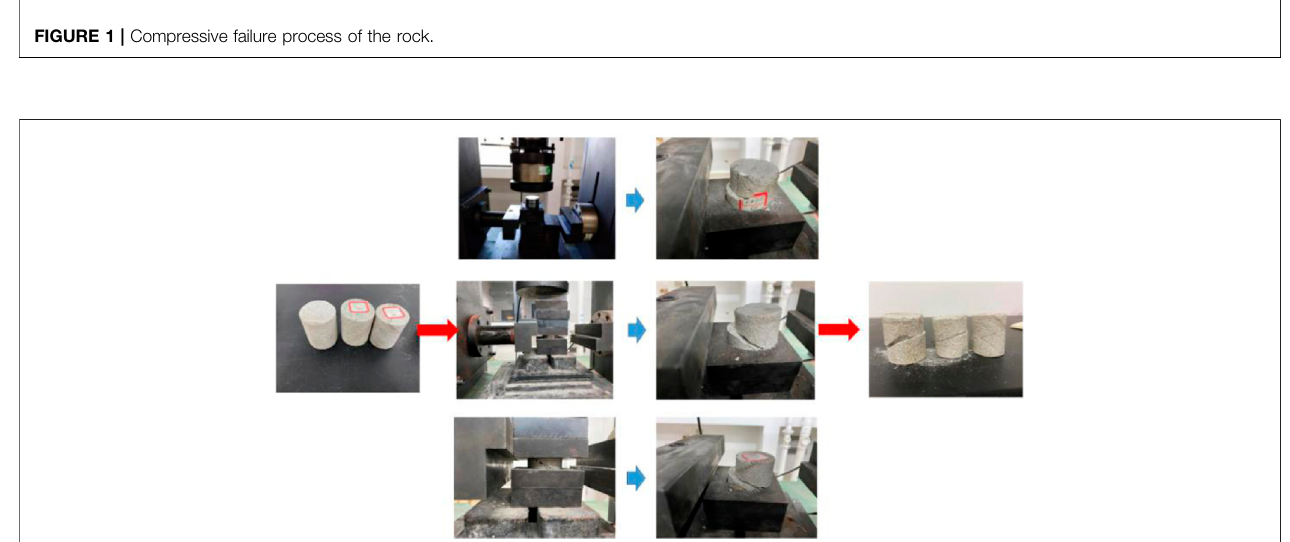
FIGURE 2 | Flow chart of the rock shear